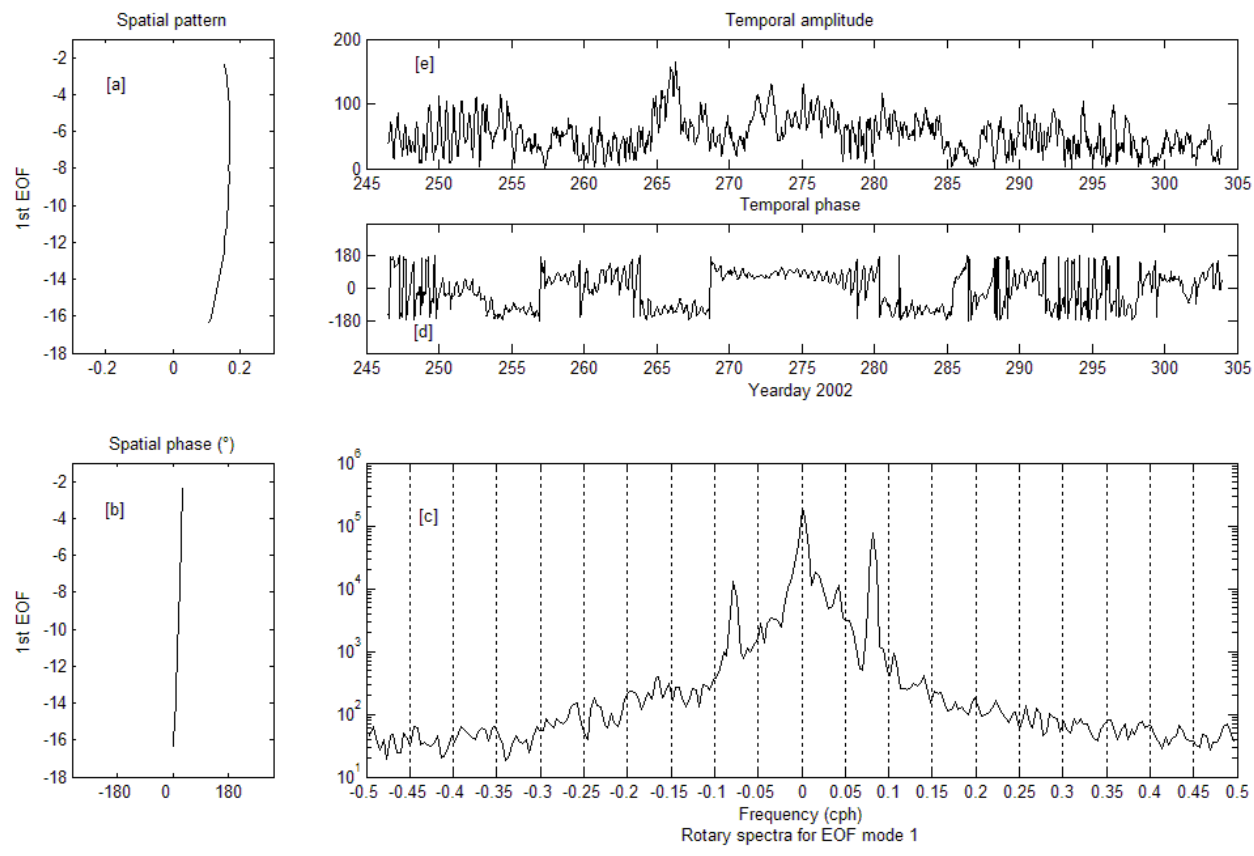
Fig. 9. Interpretation of the first EOF mode derived from the analysis of ADCP time series of current profiles at the Oceanographic Tower for the period September–October 2002. In a counterclockwise sense from the upper-left corner, the panels read as follows: (a) Spatial pattern showing the vertical structure for the first EOF mode along the water column; (b) Spatial phase showing information on phase lag form top to bottom of the water column. The spatial pattern is non-dimensional, while units for the spatial phase are degrees. Units for the vertical axis are m. (c) Two-sided rotary spectrum for the expansion coefficients associated to the EOF modes, partitioning variance into dominant time scales. Units for the y-axis are (cm/s) 2 /cph. (d) , (e) Time series of temporal phase angle and expansion coefficients, showing the time evolution of the spatial pattern over time. Units for the spatial phase angle are degrees; units for the expansion coefficients are